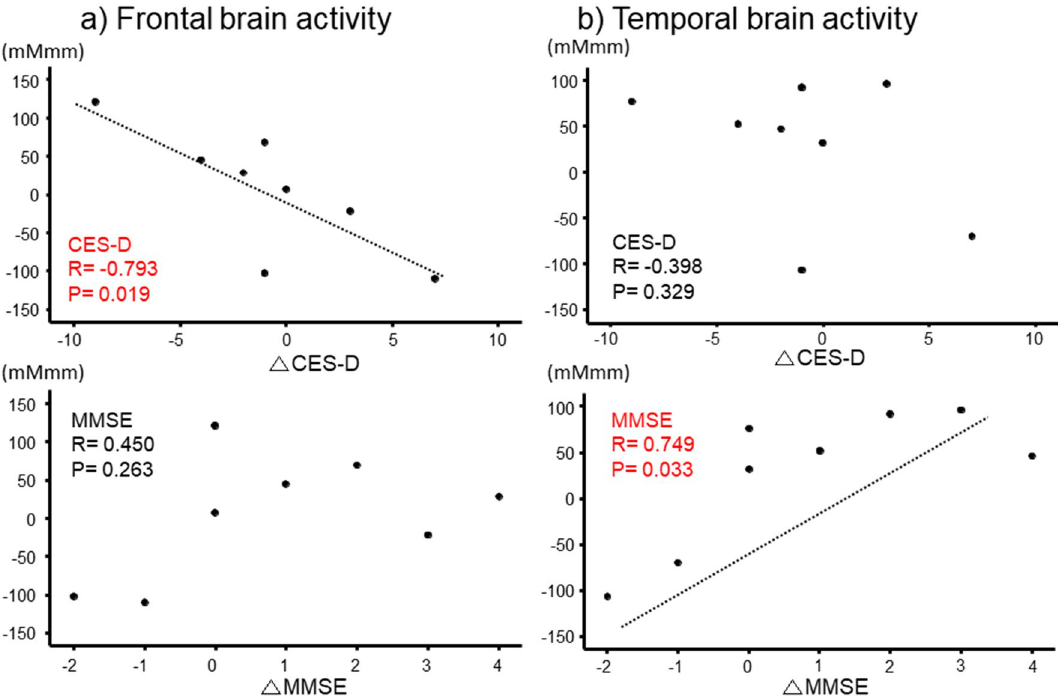
Figure 5. Correlations between changes in brain activities and changes in CES-D and MMSE (n = 8). There were significant correlations of changes in frontal brain activity with changes in CES-D (R = − 0.793, P = 0.019), but not changes in with MMSE, and there were significant correlations of changes in temporal brain activity with changes in MMSE (R = 0.749, P = 0.033), but not with changes in